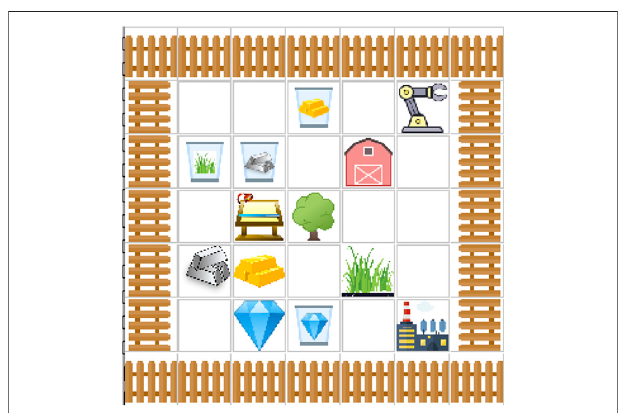
FIGURE 3 | A 7 × 7 Craft domain example showing all the various elements available in the domain. The robot is in the top right corner and is controlled by the RL agent presented in this